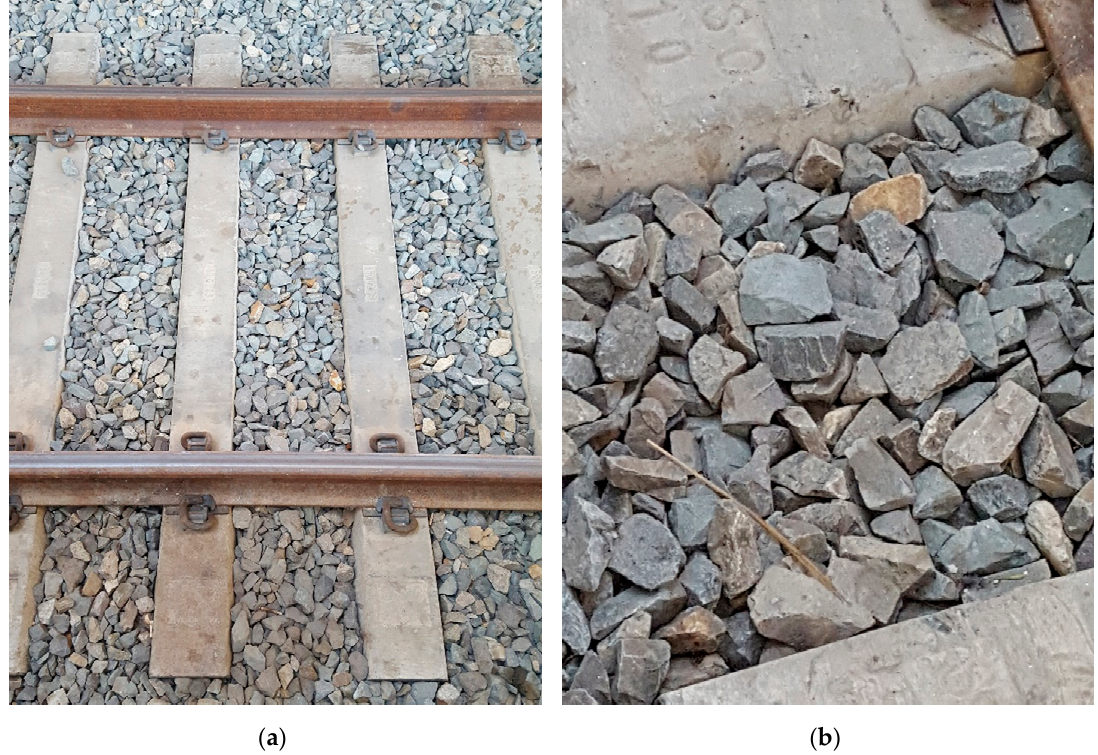
Figure 2. Conventional track ballast (ballast for rapid trains in Korea): ( a ) track ballast; ( b ) pieces of gravel for the ballast.